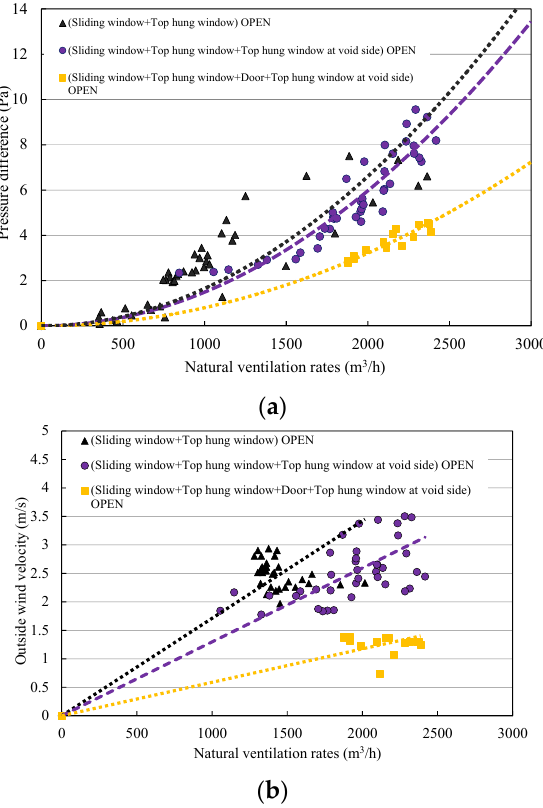
Figure 8. Measurement results of natural ventilation rates: ( a ) change in natural ventilation with differential pressure and ( b ) change in natural ventilation with external wind velocity.